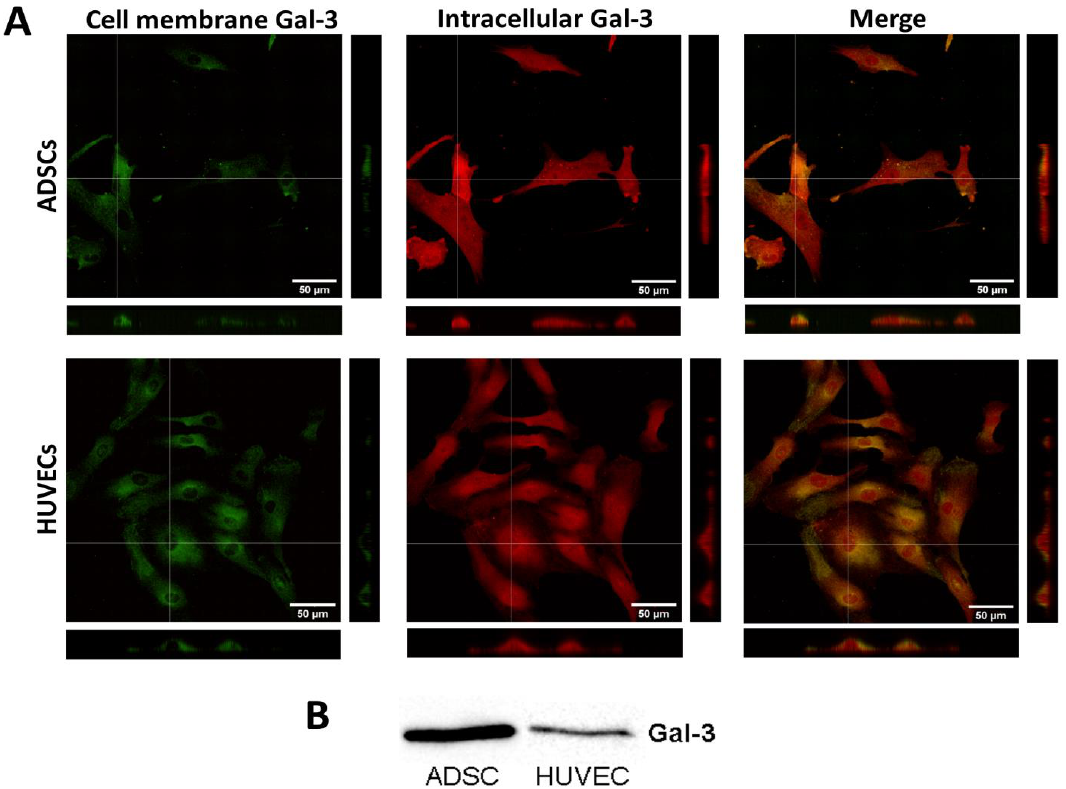
Figure 1. Localization of endogenous Gal-3 in ADSCs and HUVECs. ( A ) Immunofluorescence of Gal-3 in ADSCs and HUVECs in 1-day-old cultures. Cells were stained for Gal-3 present in the cell plasma membrane (green fluorescence) and for intracellular Gal-3 (red fluorescence). For Gal-3 staining, an anti-Gal-3 antibody produced in rabbits (Sigma-Aldrich, Cat. No. SAB4501746) was used. Orthogonal projections depict the localization of Gal-3 in the cell plasma membrane or the intracellular space. Andor Dragonfly 503 scanning disc confocal microscope; Zyla 4.2 PLUS sCMOS camera; objective HC PL APO 40×/1.10 W CORR CS2; scale bar 50 μm. ( B ) Western blot of Gal-3 expression in the cytosol of ADSCs and HUVECs. In both tested cell types, a Gal-3 band was detected at a size of 28 kDa.